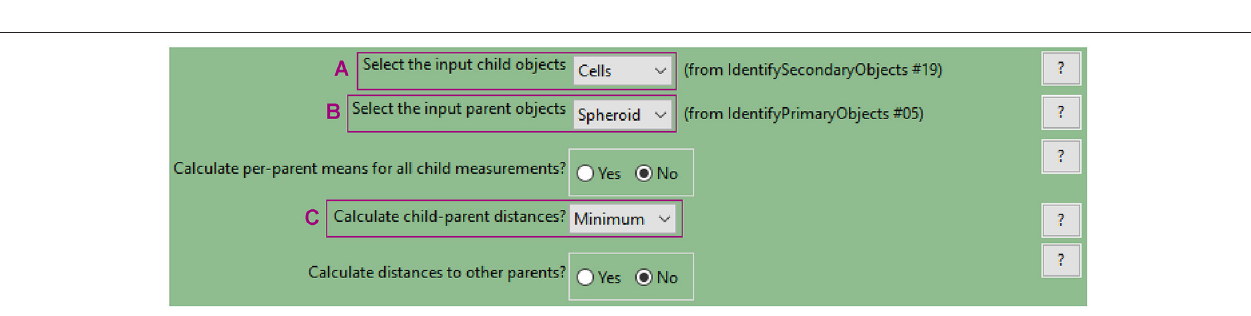
FIGURE 9 | CellProfiler “IdentifyPrimaryObjects” module. Parameters used to detect spheroid outline for analysis shown in Figure 3 .